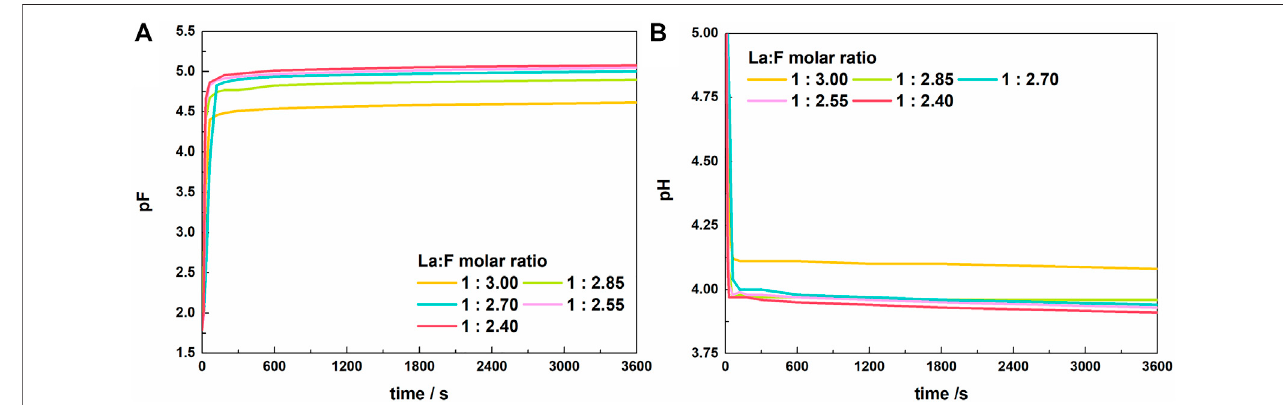
FIGURE 2 | Variations of pF (A) and pH (B) of the solution with time after adding lanthanum nitrate to the fl uorine-containing synthetic solutions with different La/F molar ratios (La/F ≥